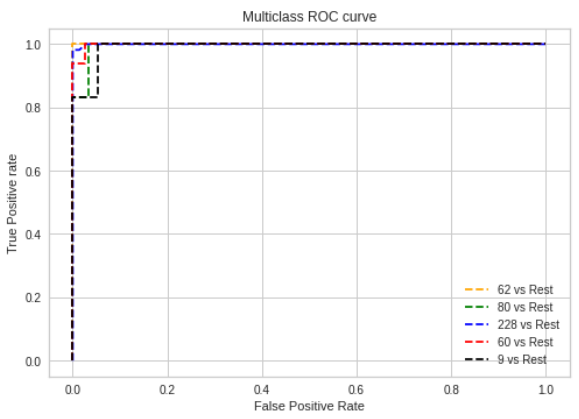
Figure 12. ROC curve for multiclass